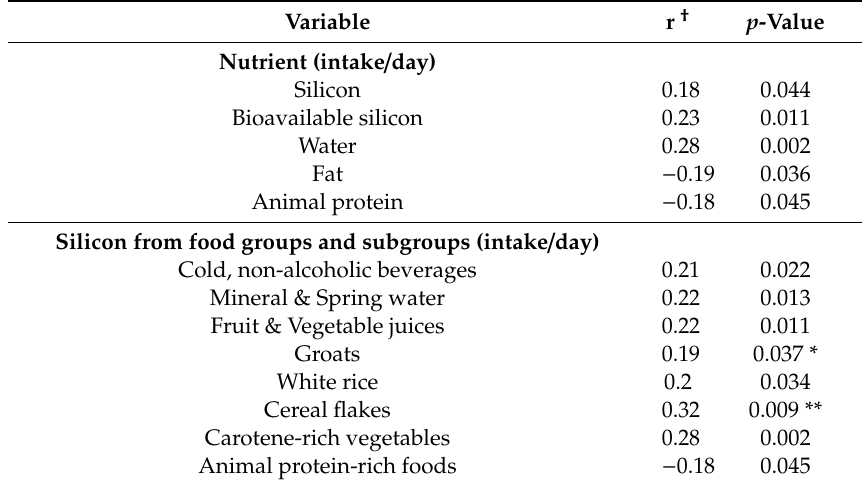
Table 5. Significant partial correlations between plasma silicon level and dietary variables ( n = 126). Variable r † p -Value Nutrient (intake / day) Silicon